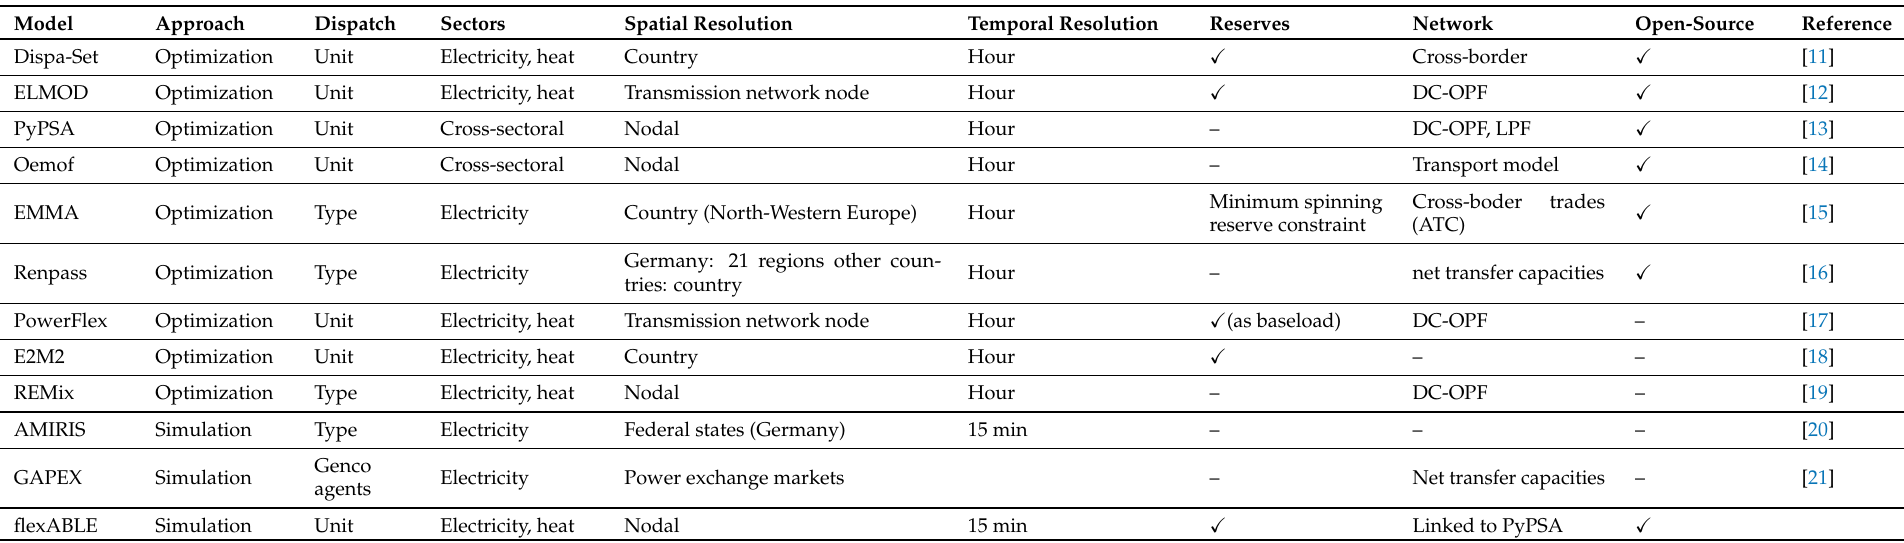
Table 1. Energy system models and frameworks with similar research scope to